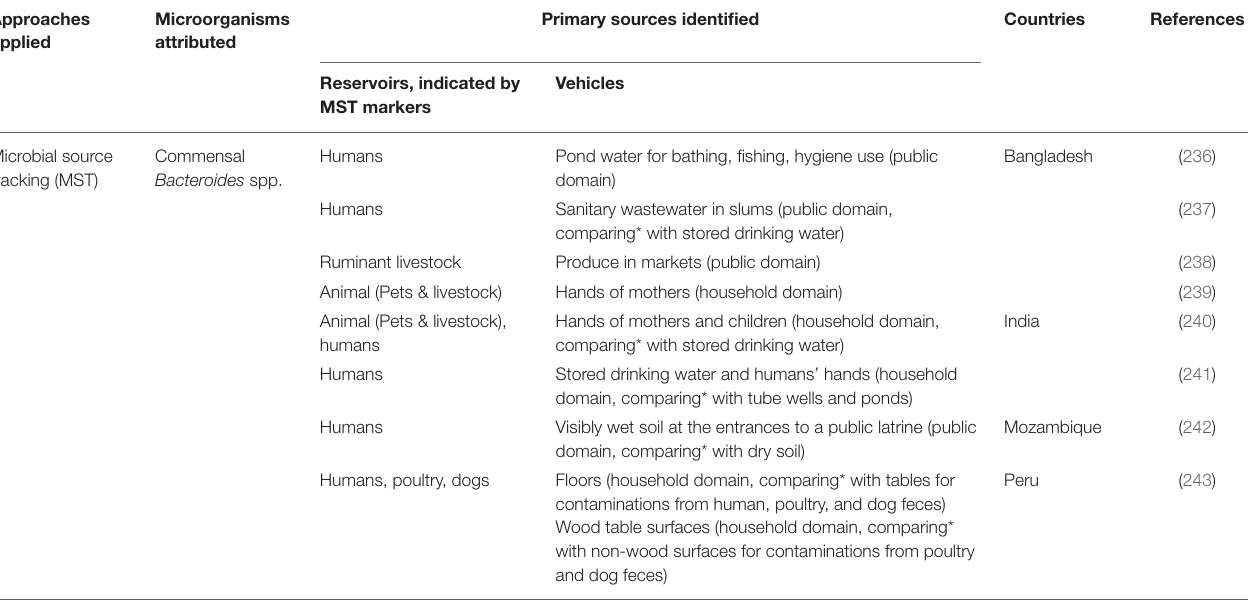
TABLE 7 | Applications of host-specific microbial source tracking (MST) markers of fecal contamination in low-resource settings. Approaches